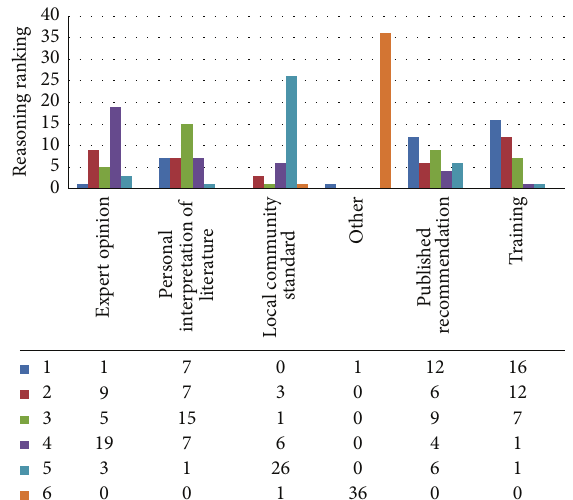
Figure 1: Reasoning behind surveillance strategies. Respondents numerically ranked reasoning options 1–6, with 1 being the most important reason supporting surveillance protocol. The majority (16 of 36 respondents) ranked continuation of the protocol used during training as the most important reason for current surveillance strategy. For those noting published recommendations, all referenced NCCN guidelines as their resource, with one respondent also referencing COG.